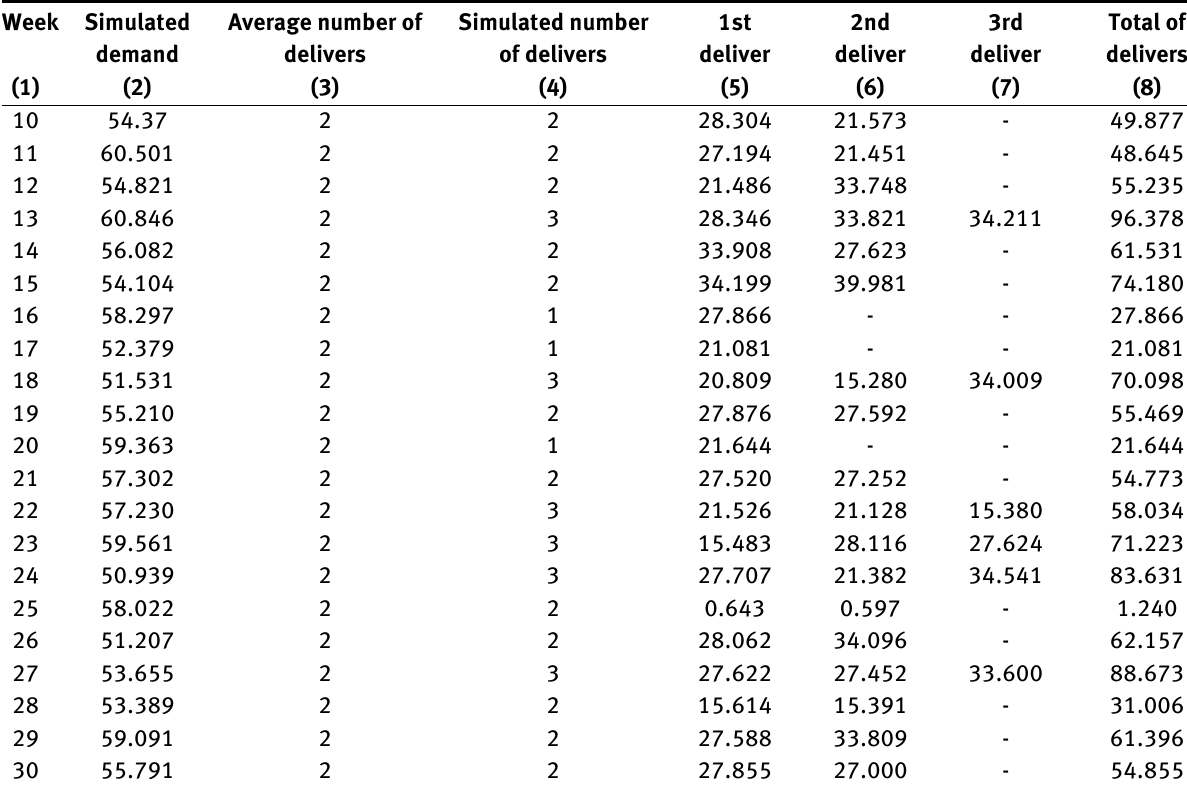
Table 3: Simulated demand obtained in one specific run of the simulation